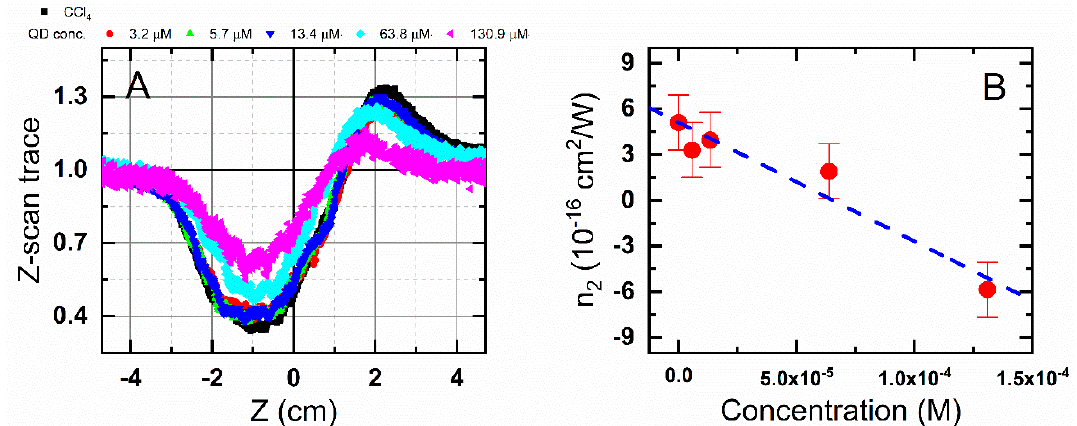
Figure 4. ( A )—Z-scan traces of the QD solutions with QD concentrations 5 × 10 − 6 M–1.3 × 10 − 4 M. ( B )—QD NRI is linearly scaled with QD concentration, the point with zero concentration corresponds to the NRI of the pure solvent, blue line—linear fit of the experimental data.